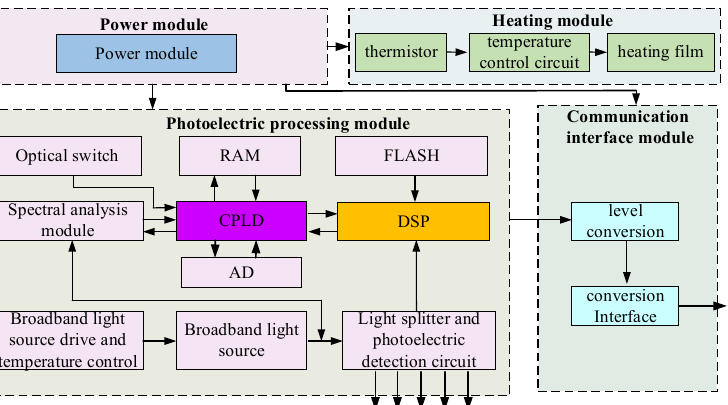
Figure 3. Hardware implementation of the matched FBG demodulation equipment.